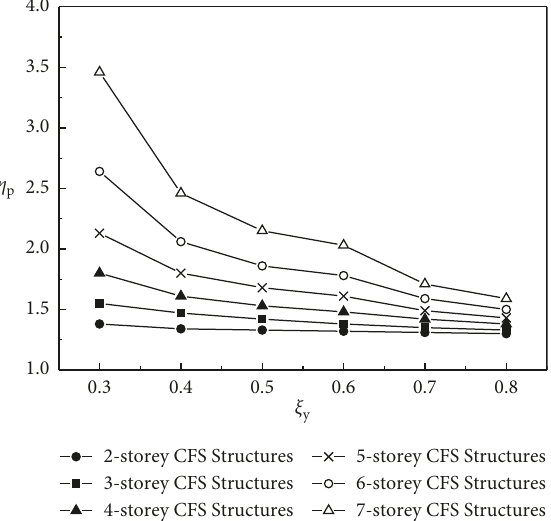
Figure 16: Suggested ξ y - N - η p relationship for seismic design.